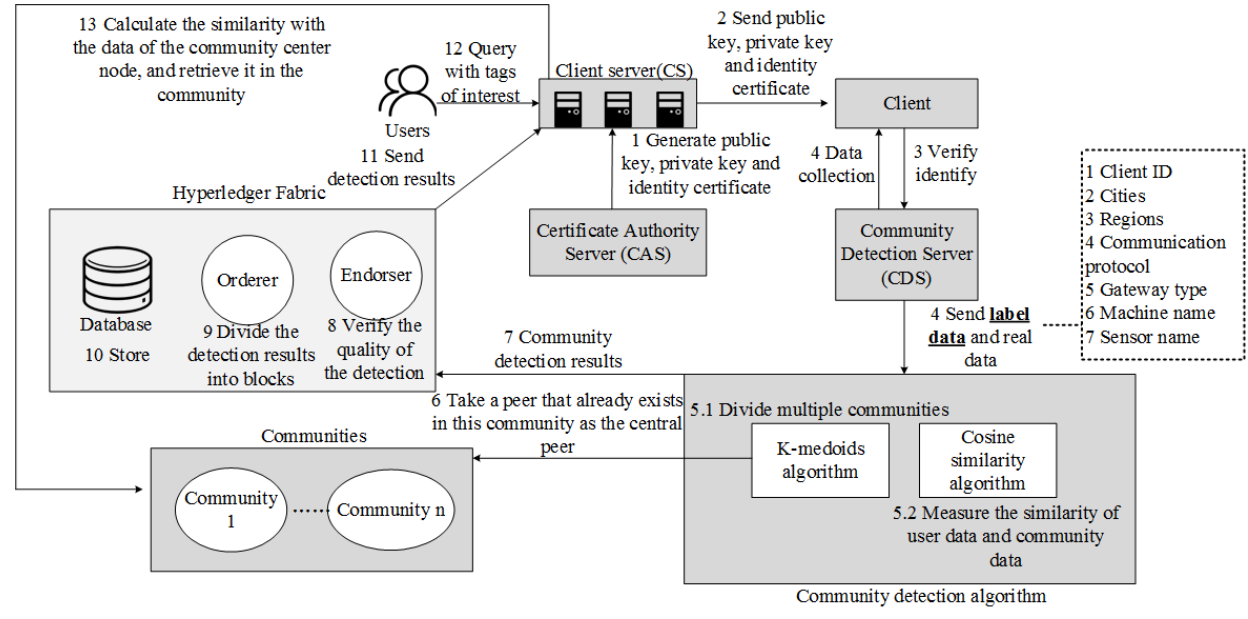
Figure 13. Reconstruction diagram of reference [34].